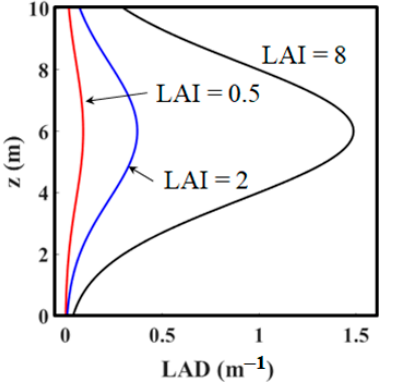
Figure 2. Distribution of the canopy leaf-area-density (LAD) in the vertical z -direction obtained from Equation (1), corresponding to a leaf-area-index (LAI) = 0.5, 2, and 8.